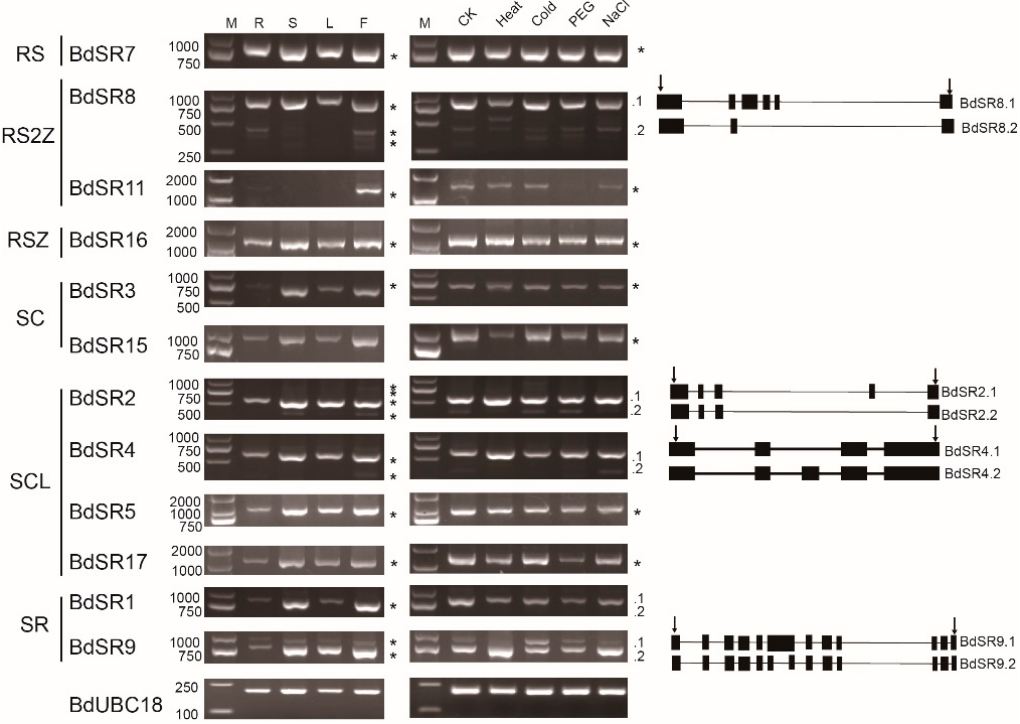
Figure 7. Expression pattern and AS pattern of BdSR protein genes. M, R, S, L, and F indicate DL2000 marker, root, stem, leaf, and inflorescences in plants. CK (H 2 O), Heat, Cold, PEG, and NaCl represent different abiotic stresses. The diagram on the right of the polymerase chain reaction (PCR) indicate different isoforms, arrows indicate primers.